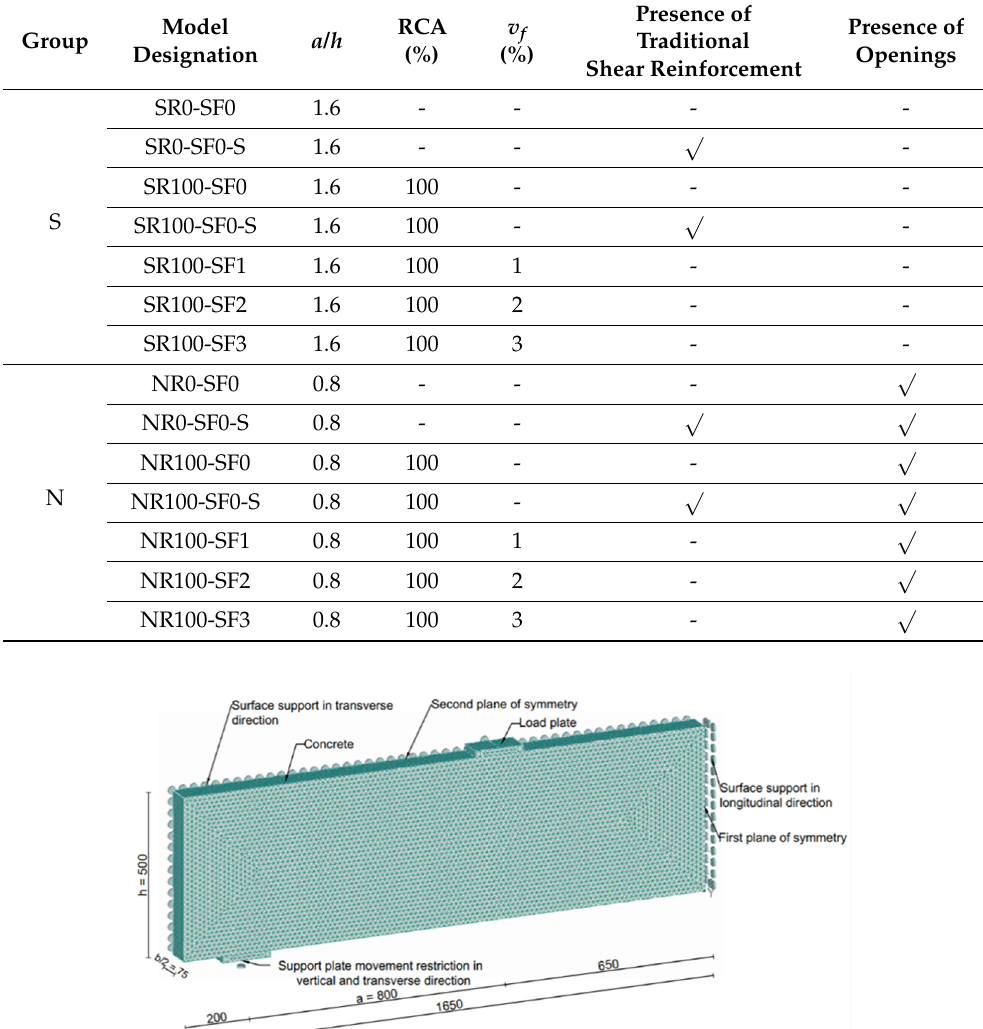
Table 2. Summary of deep beam models.